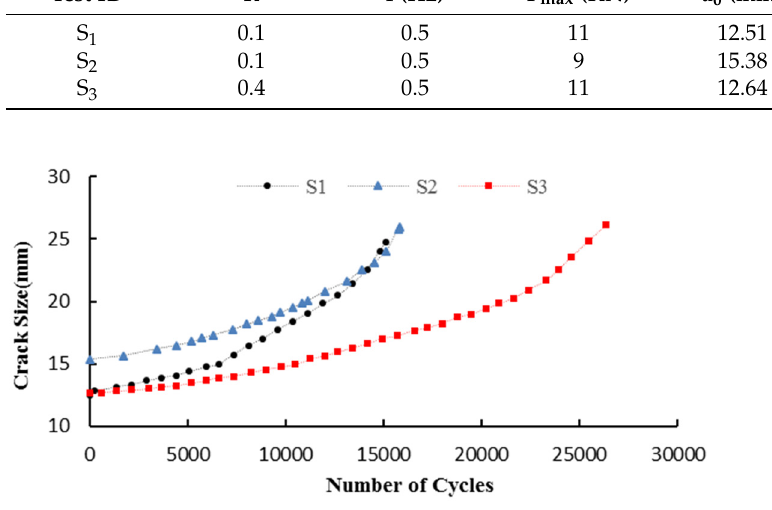
Figure 2. a-N fatigue test result extracted from [5].